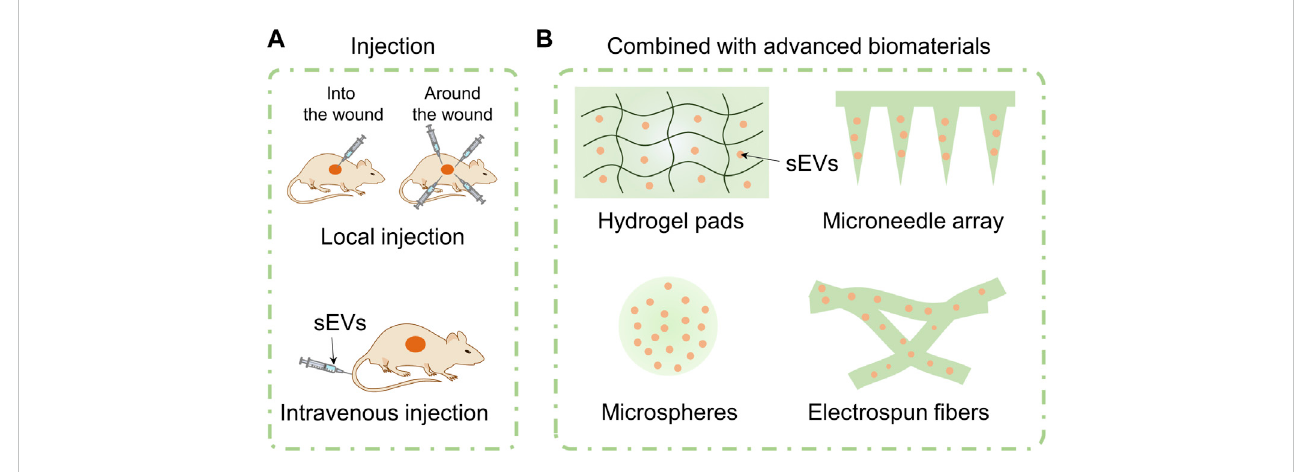
FIGURE 4 Application avenues of sEVs including injection of free sEVs and combination with advanced biomaterials. Free sEVs are applied by means of local injection or intravenous injection (A) . MSC-sEVs are loaded in hydrogel pads, microneedle array, microspheres, and electrospun fi bers (B)